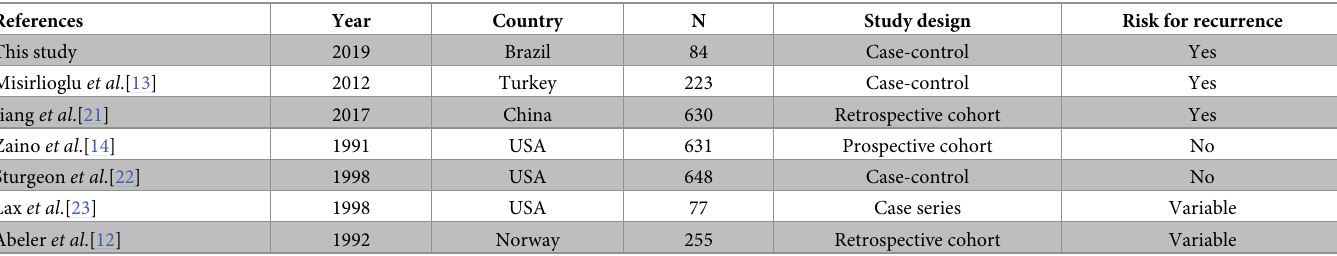
Table 3. Summary of squamous differentiation endometrioid endometrial cancer studies to predict